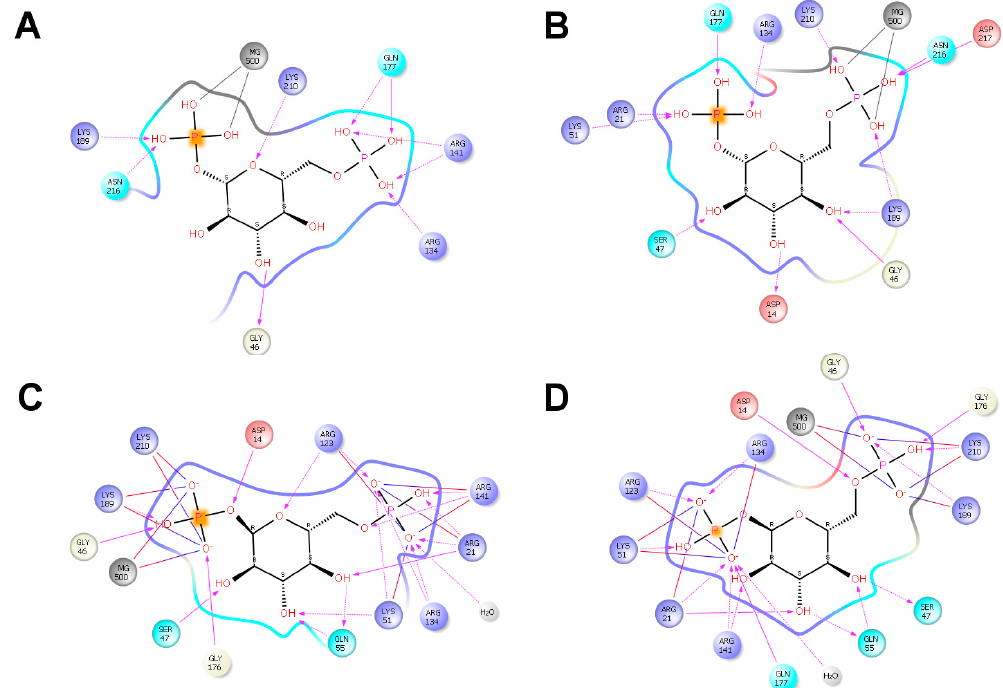
Figure 3. Interactions between PMM2 and ligands: residues that interact with β G16P by hydrogen bonds or salt bridges in P1_Mg mode ( A ) and P6_Mg mode ( B ) respectively; residues that interact with α G16P by hydrogen bonds or salt bridges in P1_Mg ( C ) mode and P6_Mg mode ( D ) respectively. When the core and cap domains close up, the solvent accessibility of some residues changes.